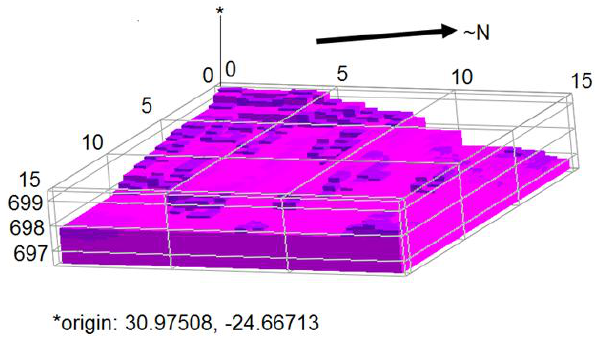
Fig. 14. Pseudo 3-D IP section of the wetland-footslope interface with chargeability values filtered to between 0–1ms. Scales are in metres diverging from a geographical origin, vertical scale is alti- tude